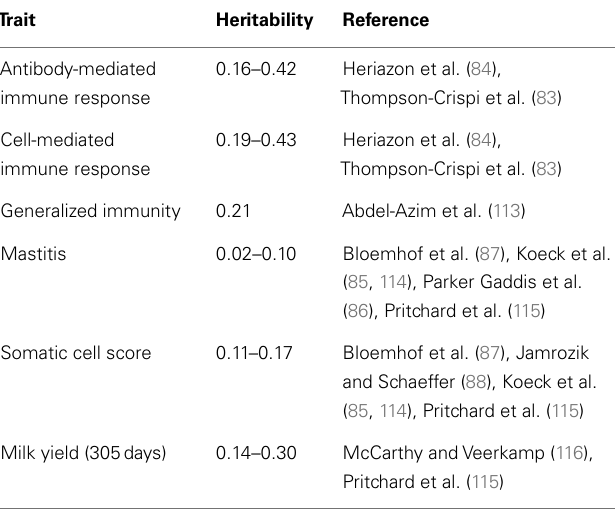
Table 1 | Heritability estimates of immune response, mastitis resistance, and milk production and in Holstein dairy cattle